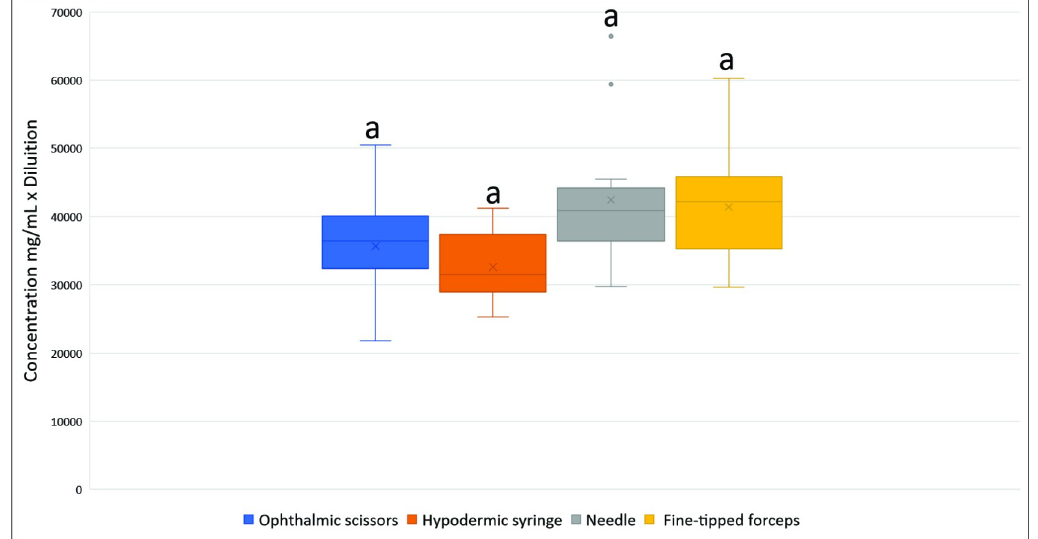
Fig 5. Boxplots comparing protein concentrations in mg/mL (Bradford method) of hemolymph samples from fifth instar larvae of A . mellifera obtained from different extraction techniques. Boxplots followed by the same letter do not differ by Tukey’s test at 5% probability (p < 0.05).